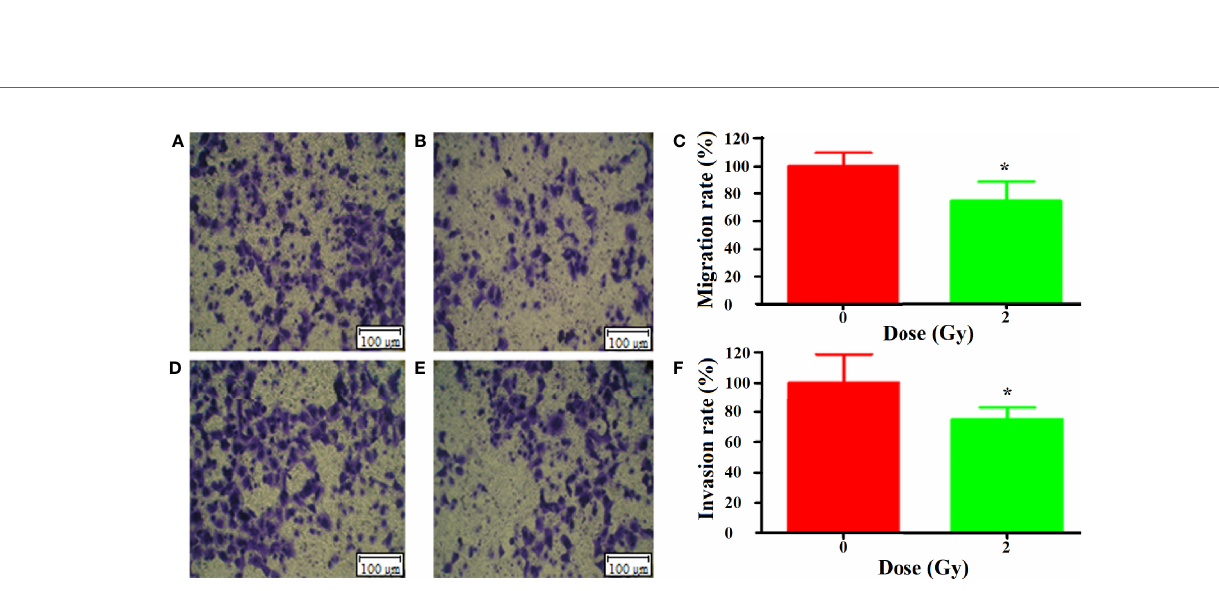
FIGURE 3 | Bystander effect of carbon ion ( 12 C 6+ ) 2 Gy irradiation on metastasis of A549 cells [ (A) 0 Gy migration, (B) 2 Gy migration, (C) mobility difference analysis; (D) 0 Gy invasion, (E) 2 Gy invasion, (F) analysis of the difference of invasion rate]. "*p <